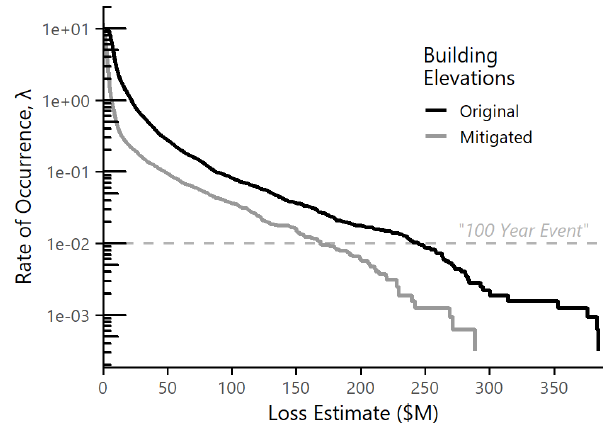
Figure 11. AR flood loss exceedance curve for Sonoma County. Loss exceedance is shown before and after the hypothetical mitiga- tion action of elevating 200 households to reduce the AAL by